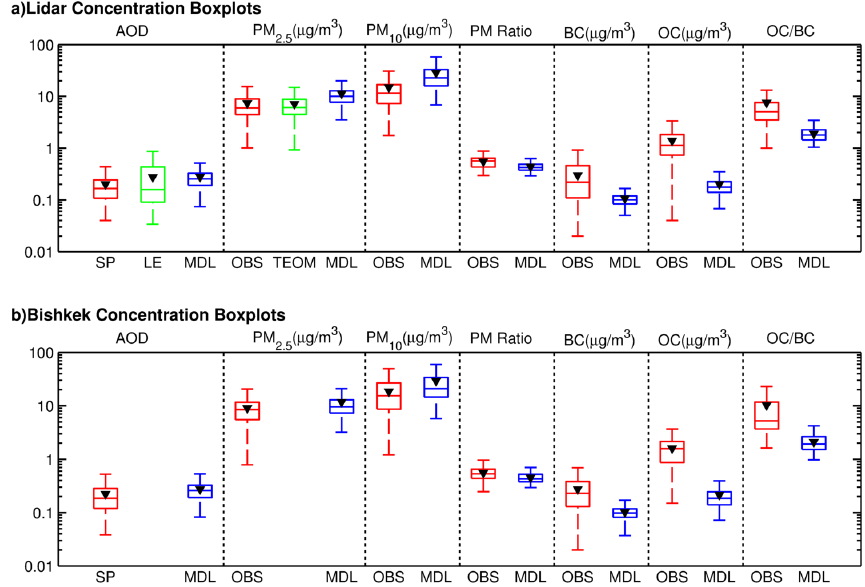
Figure 6. Comparison of predicted aerosols with observations shown as box-and-whisker plots over the simulation period at (a) LST and (b) Bishkek sites. SP and LE denote the AOD from the sun photometer (SP) and integrated from the vertical extinction profiles (LE). OBS and TEOM denote filter and TEOM measurements, while the MDL denotes the modeled values, respectively. “Lidar” denotes the LST site. In each box-and-whisker panel, the middle line denotes the median value, while the edges of the box represent 25th and 75th percentile values, respectively. The whiskers denote the maximum and minimum values. The triangle marker denotes the mean